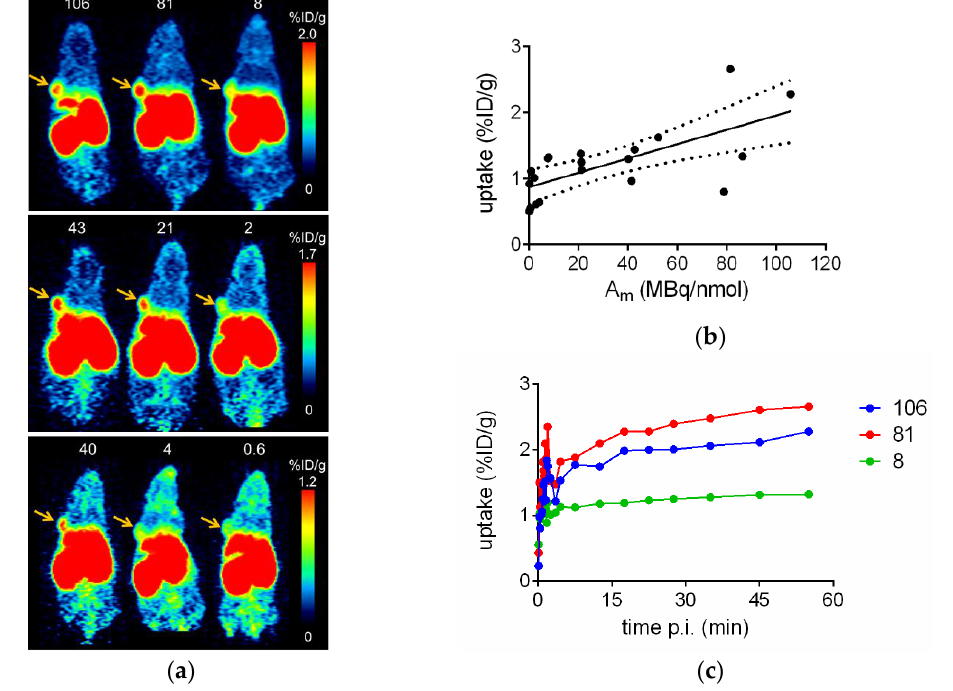
Figure 4. ( a ) Small animal PET scans of three different HT29-bearing nude mice each injected with varying amounts of [ 68 Ga]Ga-TRAP(NT4) 3 on three consecutive days, resulting in different molar radioactivities at the time of injection. Depicted are frames from 40 to 60 min; arrows indicate the tumors; ( b ) HT29 tumor uptake at 50–60 min p.i. expressed as percent of injected dose per g (%ID/g) of [ 68 Ga]Ga-TRAP(NT4) 3 dependent of molar radioactivity (A m ) of eight mice each scanned two to three times. Given are single data values with the 95% confidence bands for the best fit line; and ( c ) time activity curves showing uptake of [ 68 Ga]Ga-TRAP(NT4) 3 in the HT29 tumor dependent of molar radioactivity in MBq/nmol.